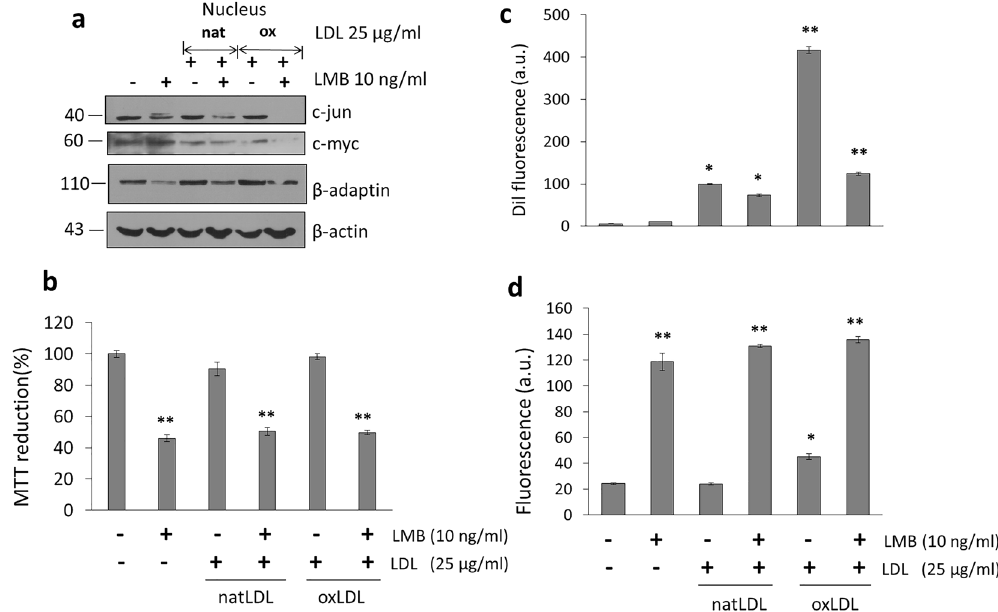
Figure 8. A prolonged LMB treatment (16 h) of macrophages induces a state of severe oxidative stress. ( a ) Western blot analysis in the expression of proteins c-Jun, c-Myc and β -adaptin present in the nuclear fraction after a prolonged LMB treatment in the presence of natLDL and oxLDL. ( b ) Under the same conditions, cell viability obtained by MTT assays. ( c ) LMB effect upon internalization of dil-fluorescently labeled natLDL and oxLDL. ( d ) ROS characterization under the same conditions. Mean values are presented (n = 6, X ± SD) * p < 0.05, ** p < 0.01.